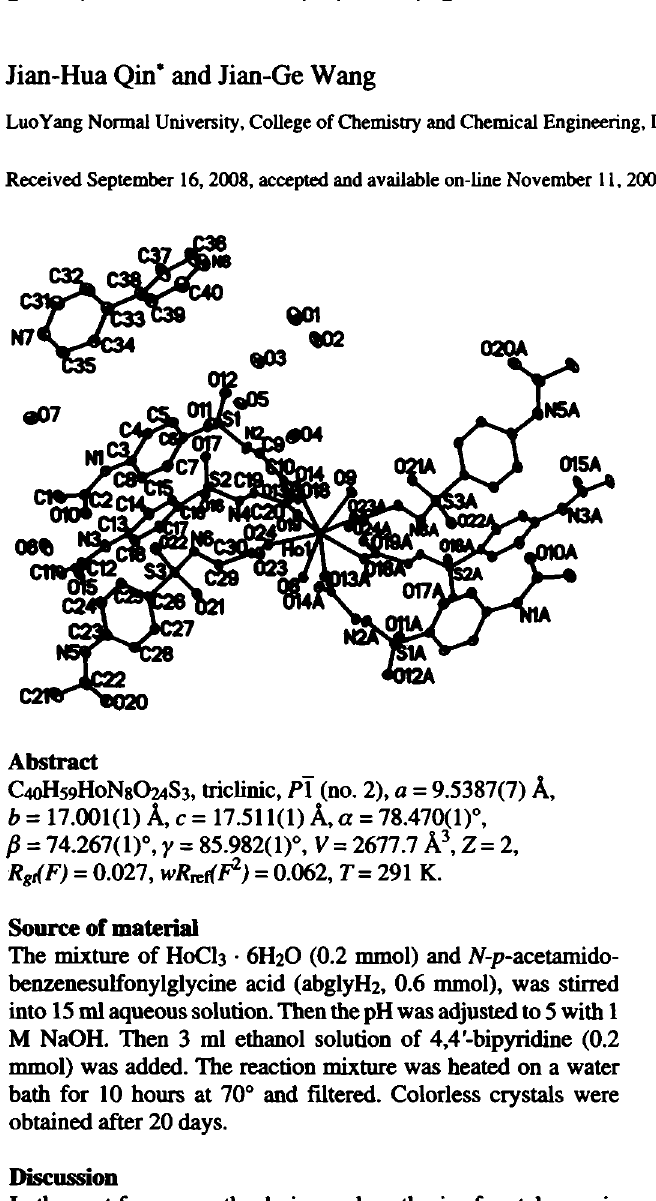
Table 2. Atomic coordinates and displacement parameters (in Â 2